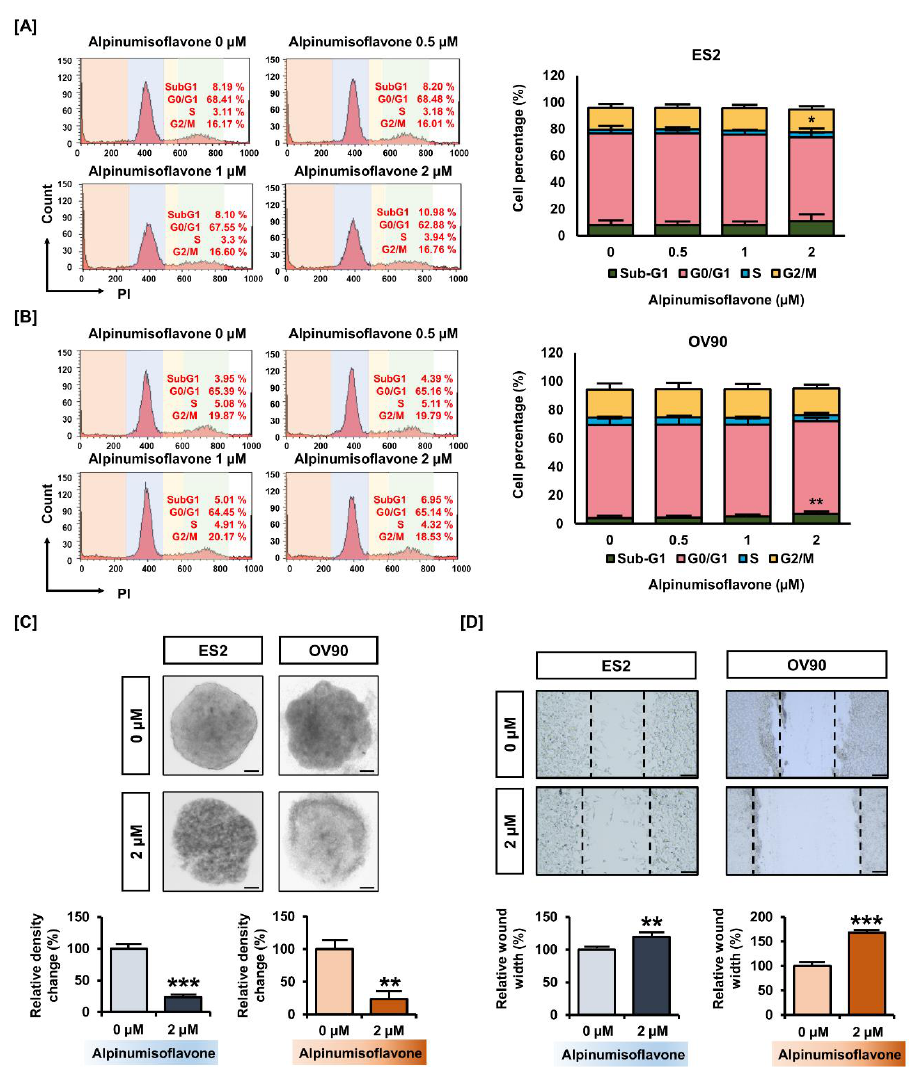
Figure 2. Change in ovarian cancer cell growth triggered by alpinumisoflavone. ( A , B ) Histogram illustration of cell cycle progression in alpinumisoflavone-treated (0, 0.5, 1 and 2 M) ovarian cancer cells for 48 h. The percentages of cells in the sub-G1, G0/G1, S and G2/M phases are presented in the comparative graph. ( C ) 3D-spheroid formation in ovarian cancer cells as examined by hanging-drop cell culture methods for cells treated with vehicle and alpinumisoflavone for 5 days. ( D ) Gap distance was calculated for detecting the migration of ES2 and OV90 cells in response to alpinumisoflavone. All experiments were performed in triplicate. The level of significance between the vehicle and treatment groups was depicted by asterisks (* p < 0.05, ** p < 0.01 and *** p <